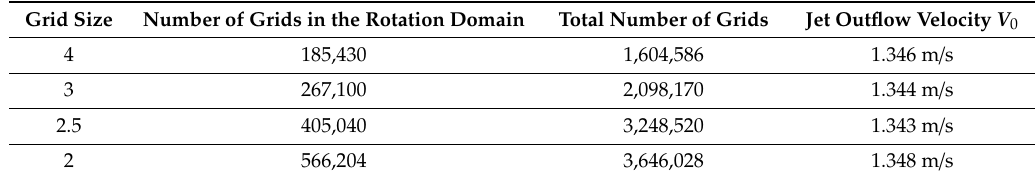
Table 2. Jet outflow velocity at each grid